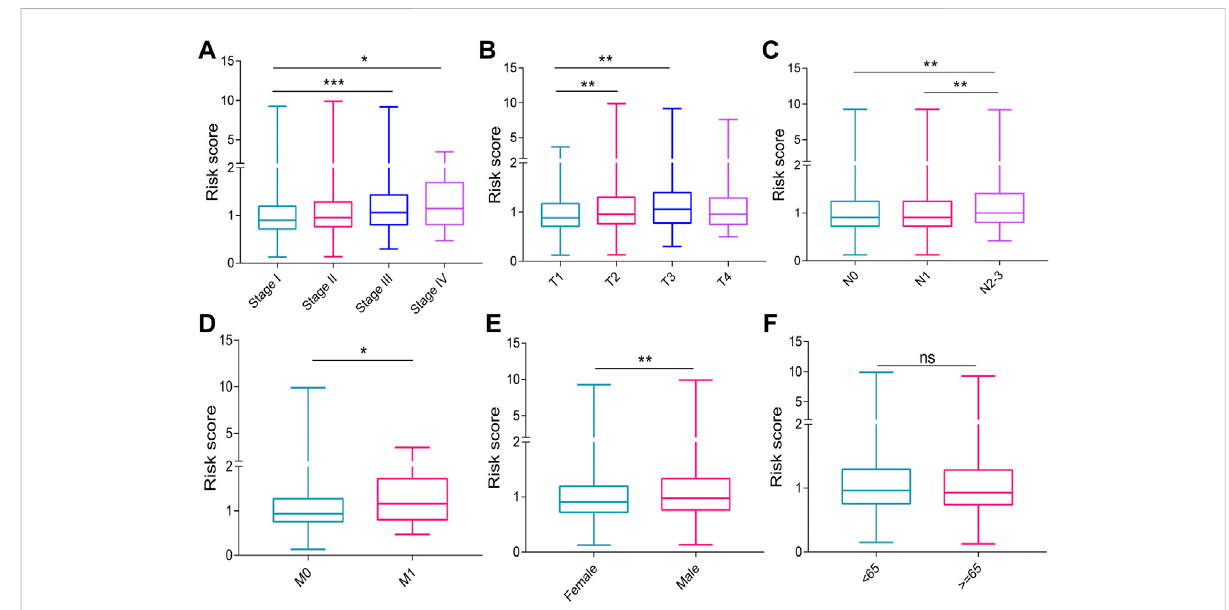
FIGURE 4 Graphsshowingthecorrelationofriskscore withclinicalcharacteristics. (A) UICCstages. (B) Tstages. (C) Nstages. (D) Mstages. (E) genders.